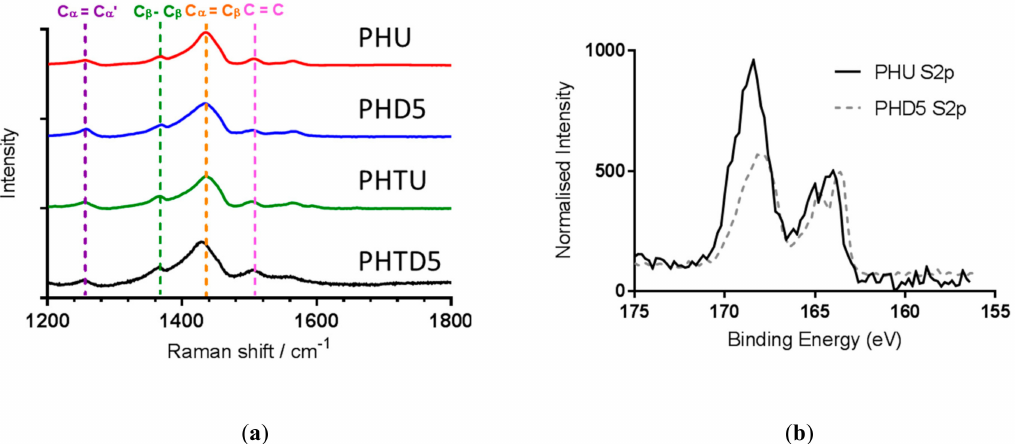
Figure 5. ( a ) Raman spectra for Clevios fibers untreated and treated with DMSO for 5 min. Untreated and 5 min DMSO treatments for PH1000 thick and PH1000 thin. ( b ) XPS spectra showing S2p emission for fibers PHU and